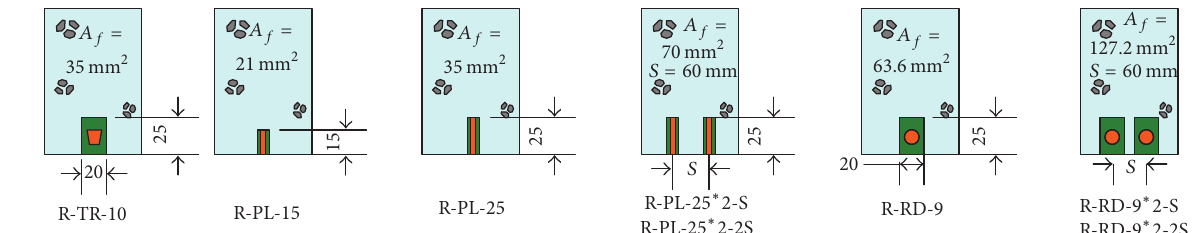
Figure 9: Cross-section of specimens strengthened by NSMR [unit: